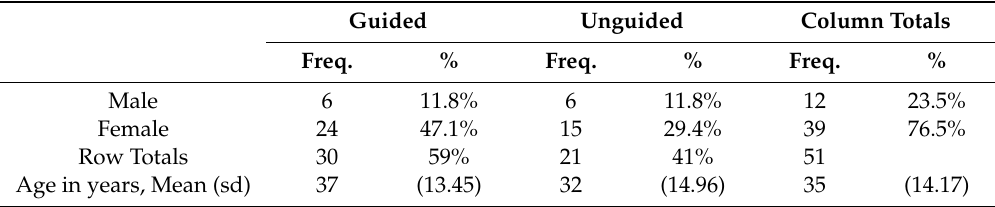
Table 1. Description of participants